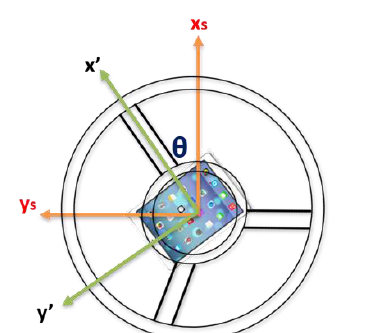
Figure 1. CPD accelerometers axes and the steering wheel fixed axis Car.